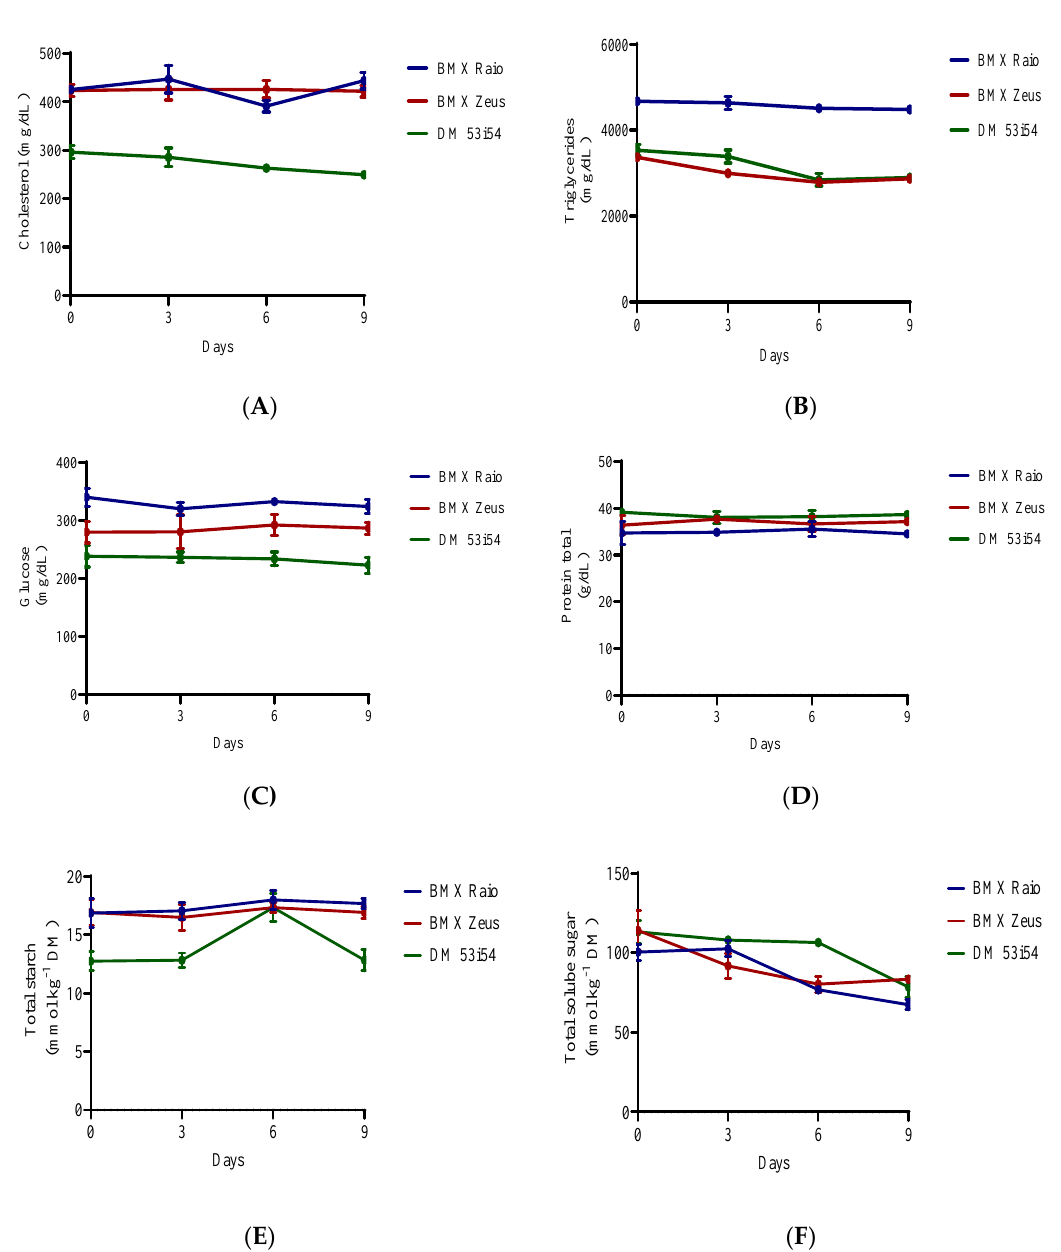
Figure 4. Cholesterol ( A ), triglycerides ( B ), glucose ( C ), protein ( D ), starch ( E ), and soluble sugars ( F ) content of soybean seed embryonic axis of three cultivars (BMX Raio, BMX Zeus, and DM 53i54) exposed to different periods of accelerated aging (0, 3, 6, and 9 days).